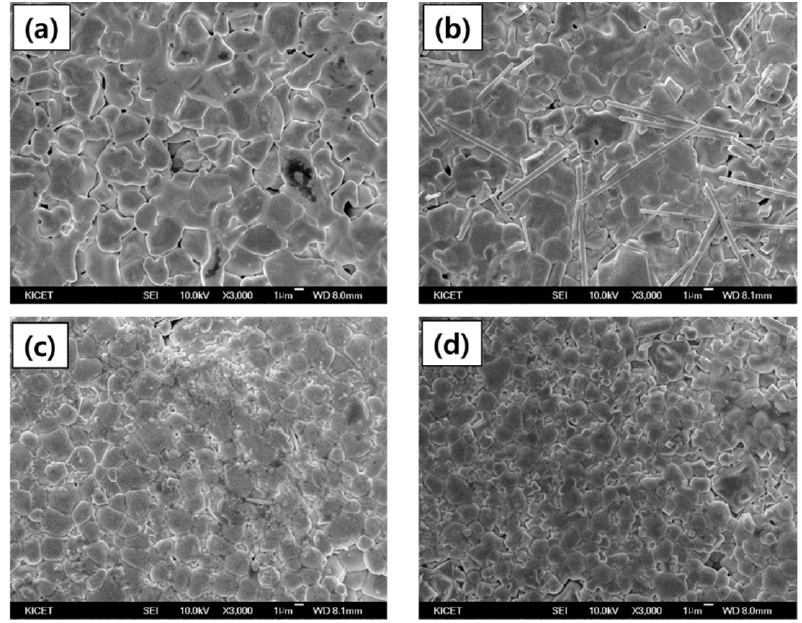
Figure 3. Microstructures of (Pb 0.88 , La 0.12 )(Zr 1 − x , Sn x ) 0.86 Ti 0.14 O 3 sintered at 950 °C according to Sn 4+ substitution ( a ) Sn 4+ = 0, ( b ) Sn 4+ = 0.2, ( c ) Sn 4+ = 0.4, ( d ) Sn 4+ = 0.6. The sintered density slightly decreased with the pores when Sn 4+ was 0.6, as seen in Figure 4. A secondary phase as a needle-shaped microstructure was formed when a 0.2 mol ratio of Sn 4+ was added to the composition. As a result of the composition analysis using EDS, this needle has relatively high ratios of Pb 3+ and Sn 4+ elements, so it can be estimated as the appearance of a secondary phase centered on